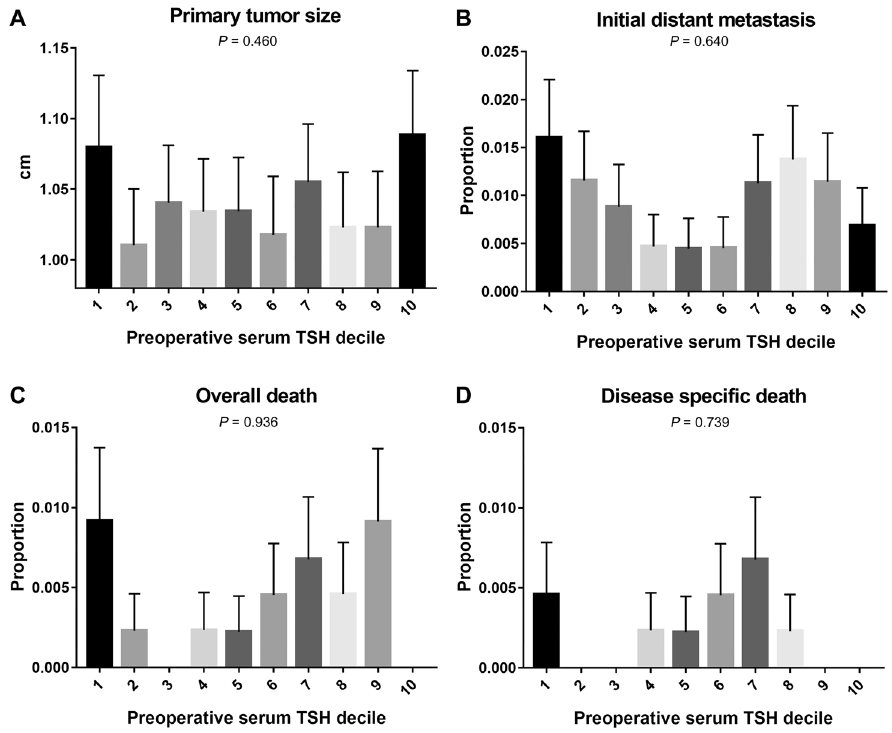
Figure 2. Pattern of prognostic marker and death of differentiated thyroid cancer according to preoperative serum TSH decile. ( A ) primary tumor size and ( B ) initial distant metastasis showed bimodal peak according to the preoperative TSH decile. ( C ) overall death and ( D ) disease specific death also showed bimodal peak according to the preoperative TSH decile, similar to primary tumor size and initial distant